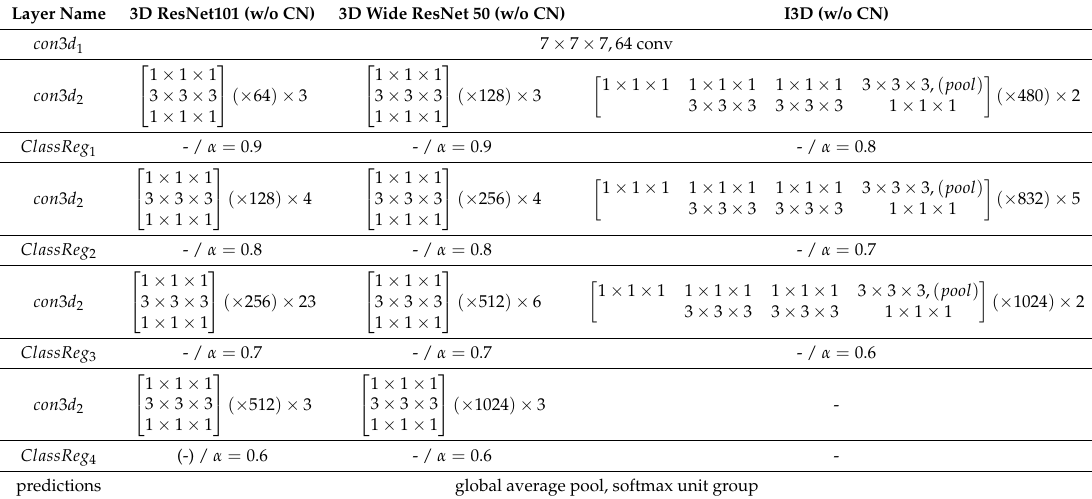
Table 1. Architectures of 3D convolution models with and without class regularization. We note that in the Class Regularized networks, only an eighth of the additional parameters are trainable, with the rest corresponding to nontrainable class weights tensor